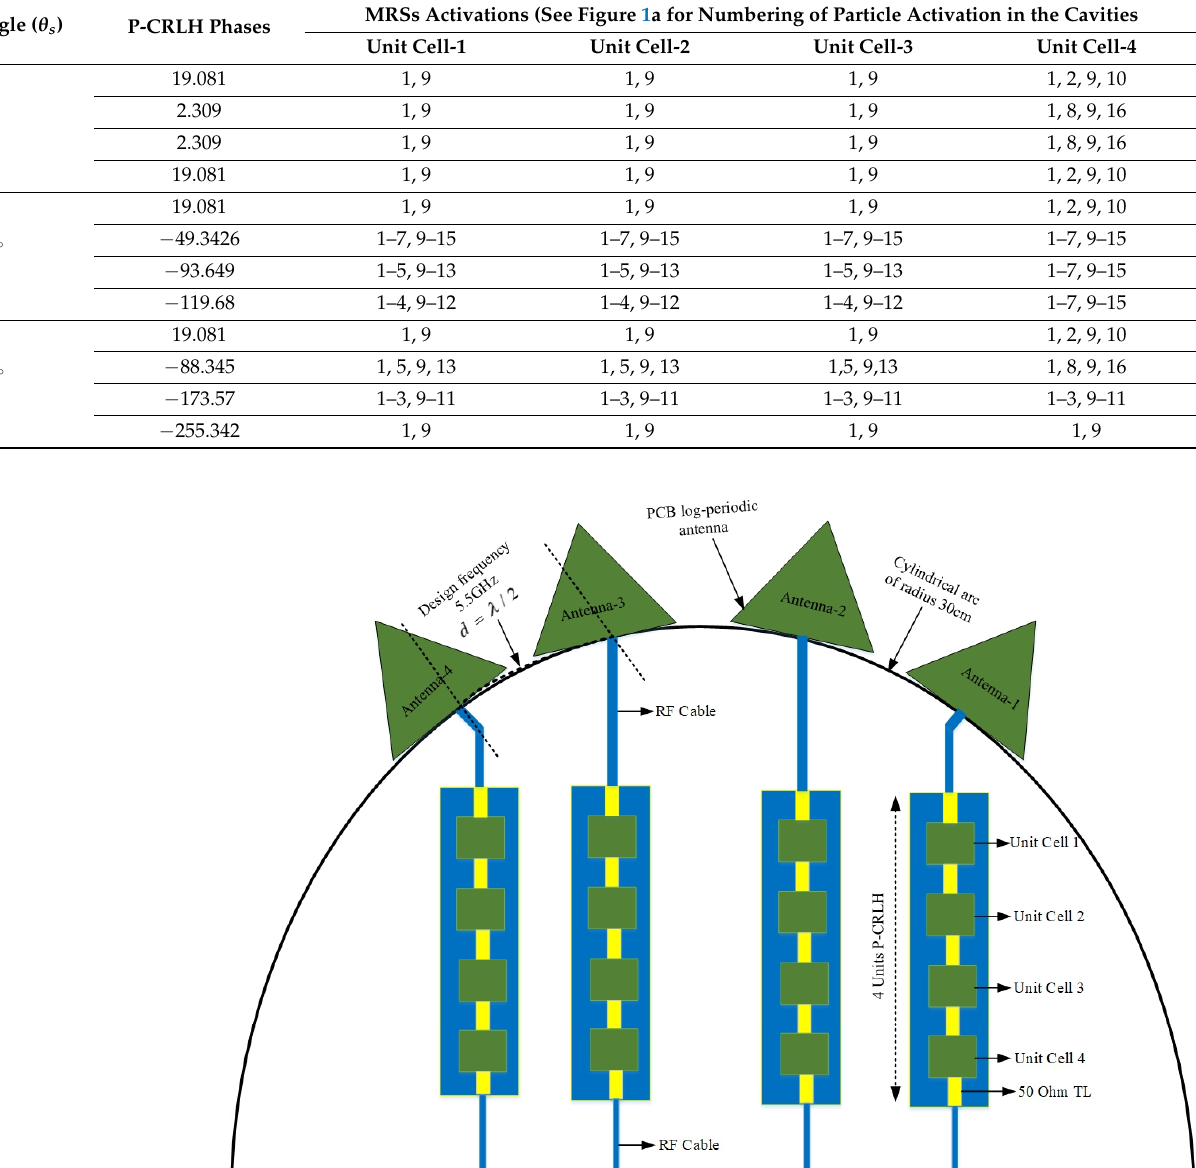
Table 2. Achieved phases (degrees) with cascaded four-unit-cell P-CRLH phase shifters.